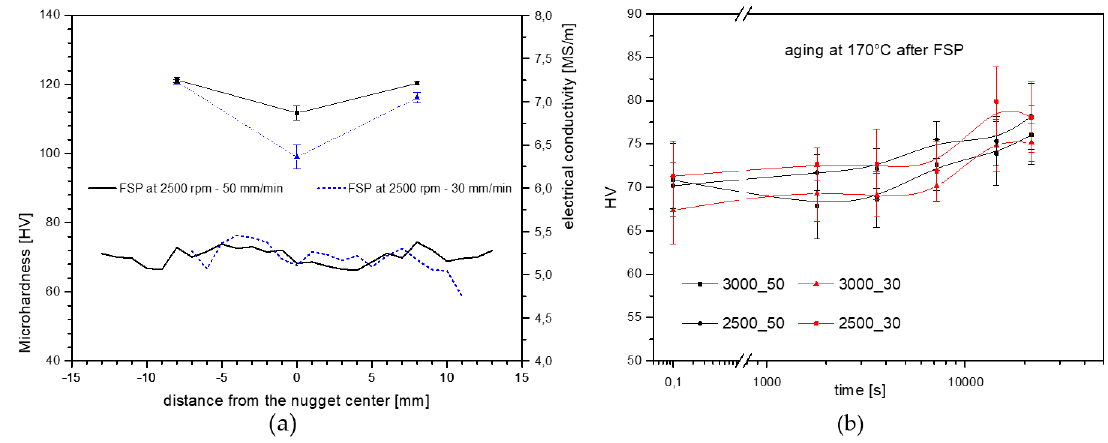
Figure 3. ( a ) Microhardness profiles and electrical conductivity values for two samples as FSPed and ( b ) average microhardness at nugget center during aging at 170 °C for each FSPed condition.